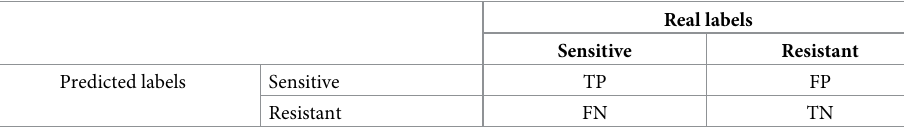
Table 1. The confusion table for defining classification